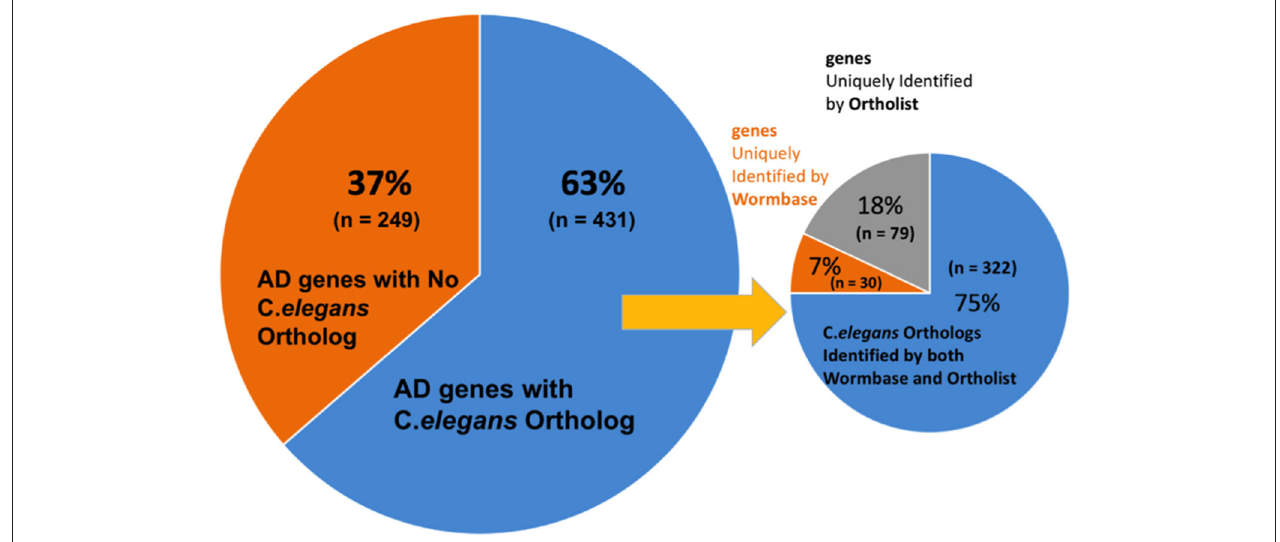
FIGURE 2 | Distribution C. elegans ortholog identification in WormBase and OrthoList. Out of 680 AD genes, 431 were identified to have an orthologous match in C. elegans . A discrepancy was observed between the two databases: 30 orthologous matches were uniquely identified by WormBase and 79 from OrthoList.